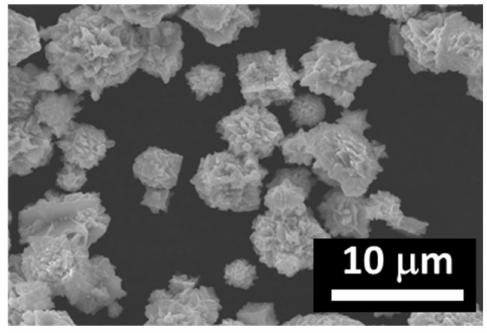
Figure 1. Carbonyl iron microparticles reduced in hydrogen.